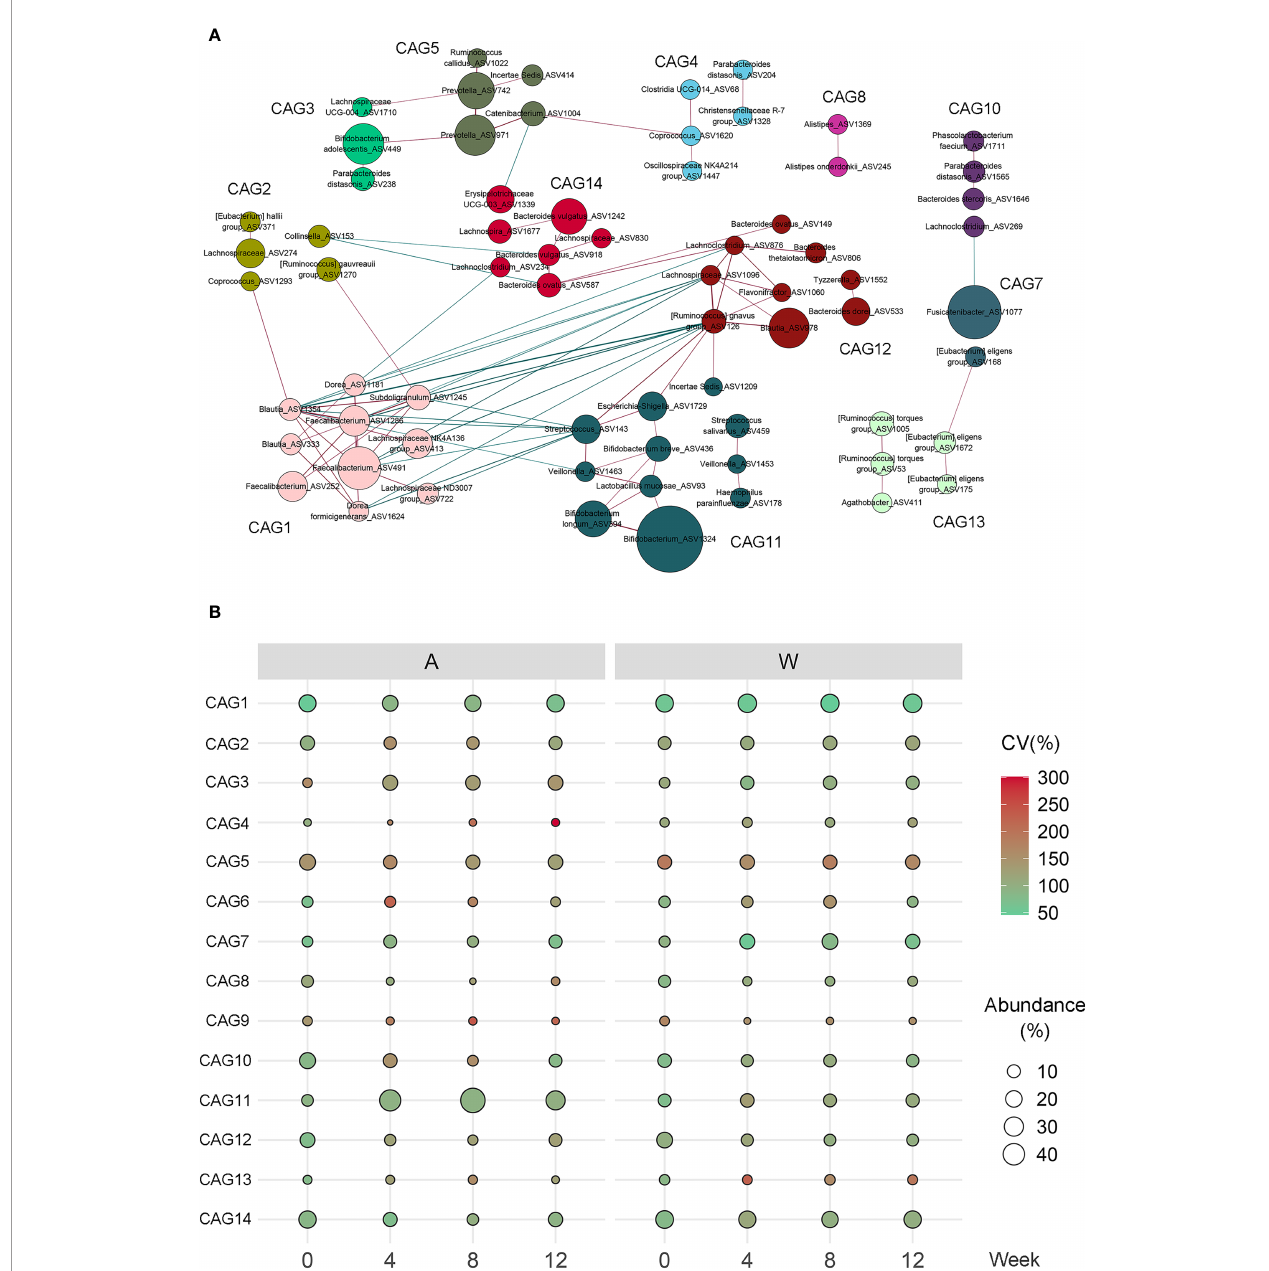
FIGURE 5 | Alterations in the abundance of CAGs in response to the intervention. (A) Co-abundance groups interaction network displays the interaction between different CAGs. Node size represents the average abundance of each ASV. Lines between the nodes indicate correlation (green = negative, red = positive), with width of the lines representing the correlation magnitude. Correlations with absolute values <0.4 are not shown here. (B) Bubble plot shows the variation in the average abundance of CAGs during the intervention. The size and color of the circles represent the average abundance and coef fi cient of variance (CV) of each CAG,